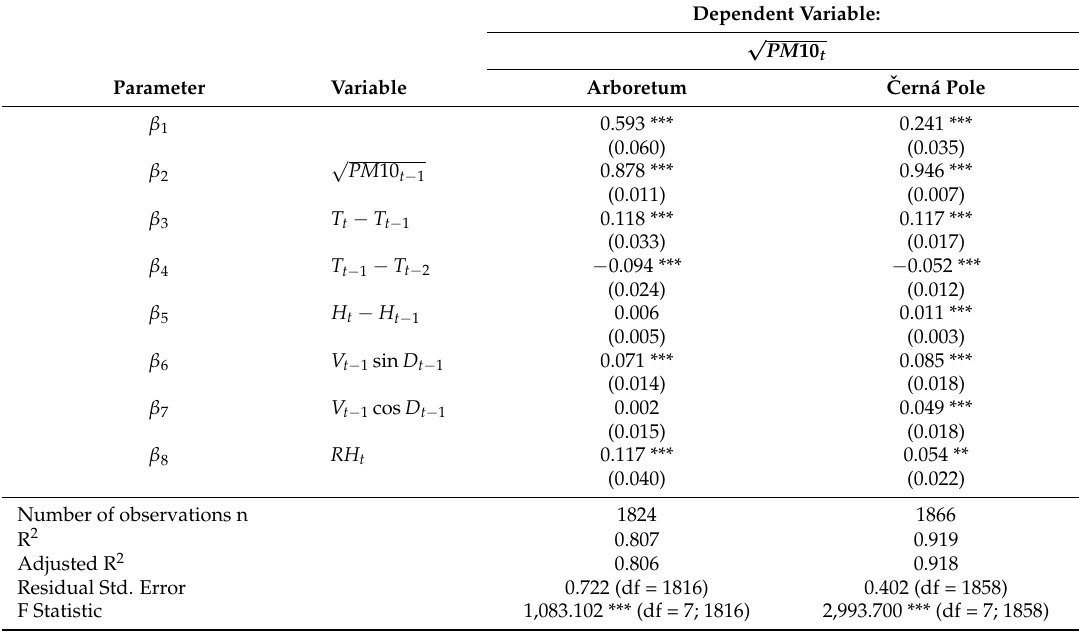
Table 3. Estimates of the linear models; standard errors are in